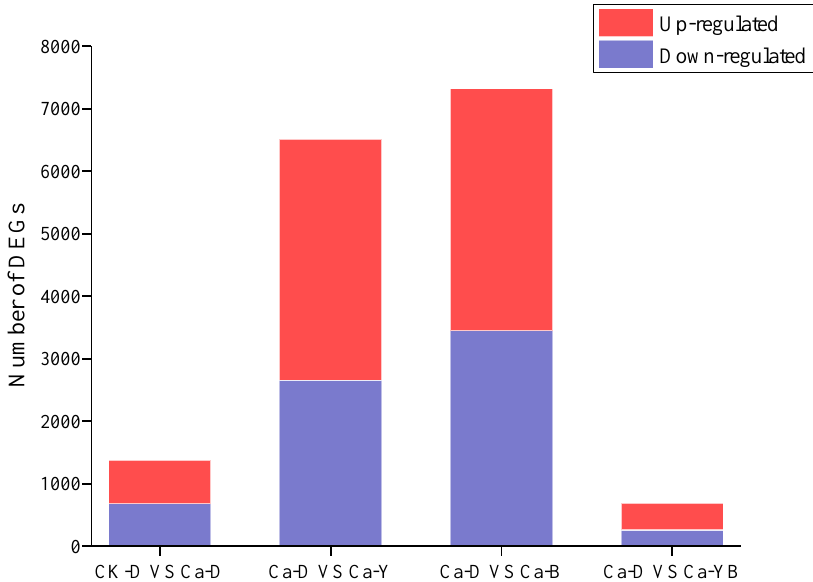
Figure 5. Number of differentially expressed genes with two-fold cut-off on fold changes. The X-axis shows the comparison group, including CK-D vs. Ca-D, Ca-D vs. Ca-Y, Ca-D vs. Ca-B, and Ca-D vs. Ca-YB. The Y-axis shows the number of genes significantly differentially expressed in each comparison group. The red represents up-regulated, and the blue represents down-regulated. Table 1. The reads, bases number, and mapping rate of the A. sinodeliciosus transcriptome.